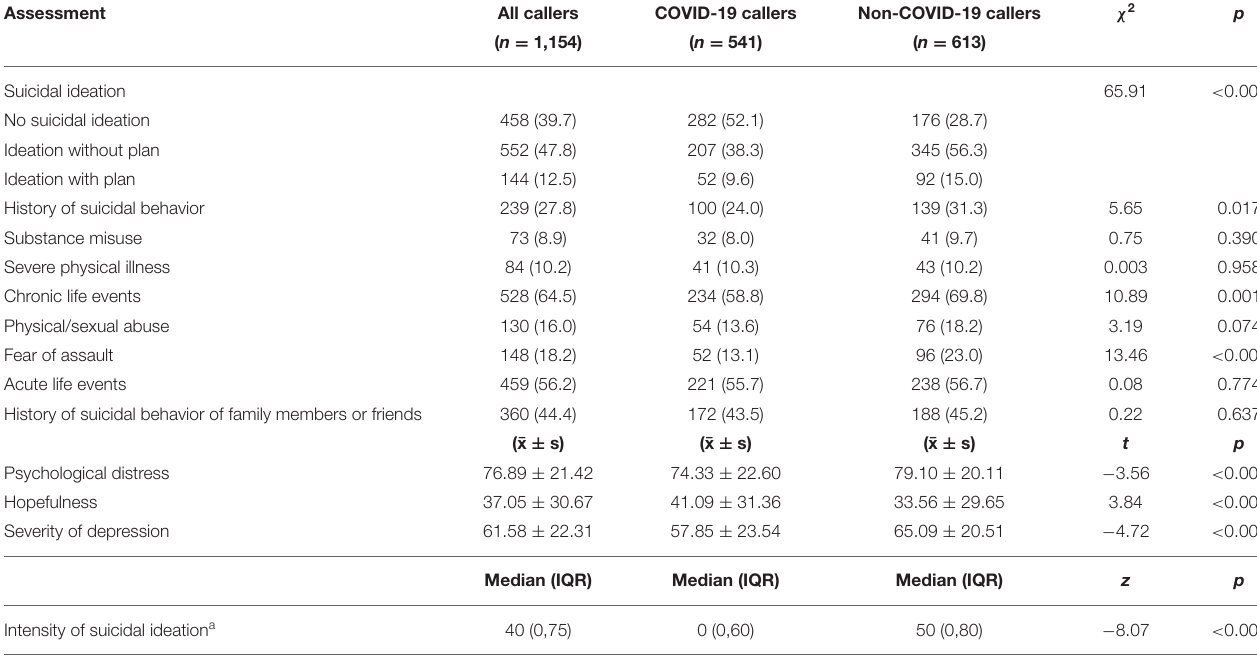
TABLE 3 | Comparison of suicidal ideation, other psychological problems, and mood assessment between COVID-19 callers and non-COVID-19 callers [ n (%)].